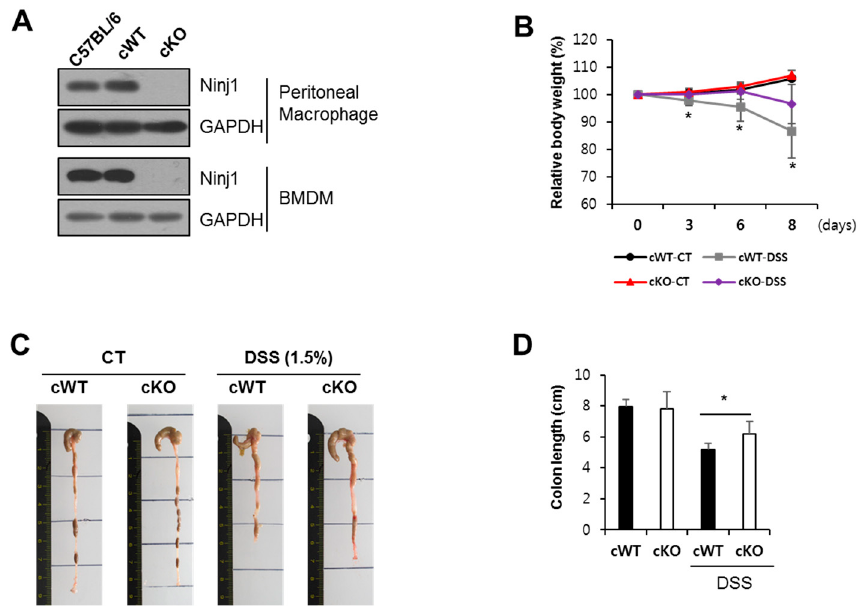
Figure 6. Ninj1 deficiency on macrophages reduces colonic inflammation during DSS treatment. ( A ) Peritoneal macrophages and bone marrow-derived macrophages were isolated from cWT (conditional wild-type: Ninj1 fl/fl ) and Ninj1 cKO (conditional KO: Ninj1 fl/fl ; Lyz-Cre+); Ninj1 was detected by immunoblotting, using GAPDH as the internal control. ( B ) cWT and Ninj1 cKO were administered 1.5% DSS for 8 days; n = 5, normal group; n = 8, DSS group. Bodyweight loss is presented as a percentage of initial weight (mean ± SD). Student’s t -test comparing 1.5% DSS treated cWT mice and 1.5% DSS treated Ninj1 cKO mice, * p < 0.05. Similar results were observed in four independent